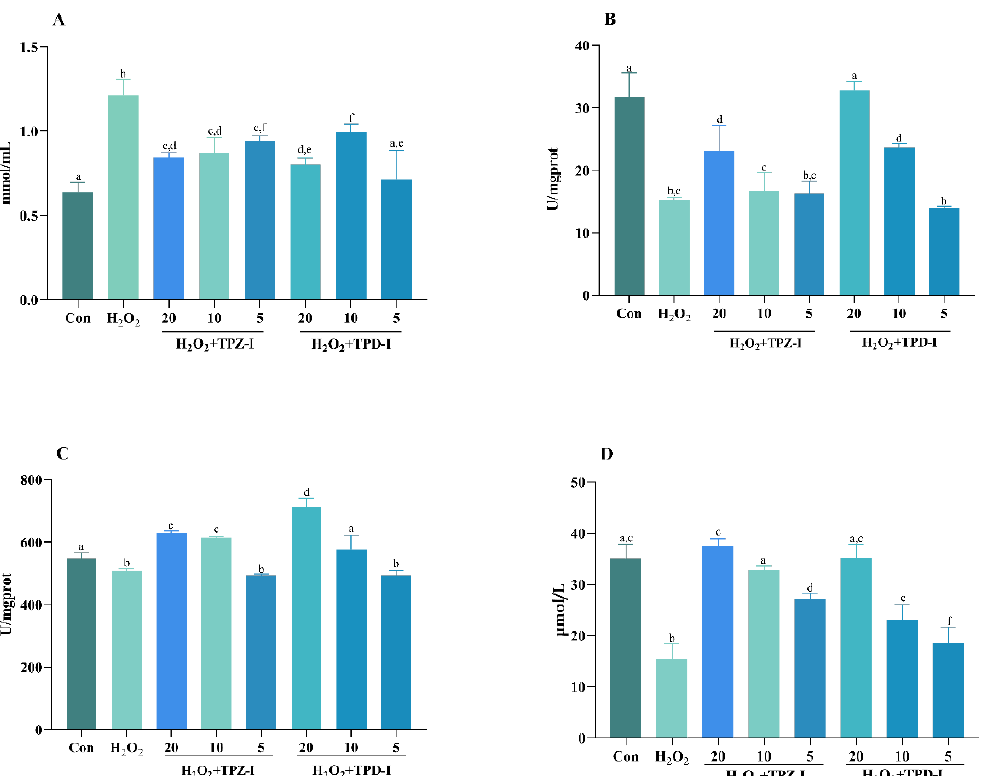
Figure 4. Effects of TPZ-I and TPD-I on the activities of malondialdehyde-MDA ( A ), superoxide dismutase-SOD ( B ), catalase-CAT ( C ), and glutathione peroxidase-GSH-Px ( D ) in IPEC-J2 cells. The concentrations of the polysaccharide fractions were 20, 10, and 5 μg/mL, respectively. Values are presented as means ± SD ( n = 6). Bars with different letters are statistically significant ( p < 0.05).